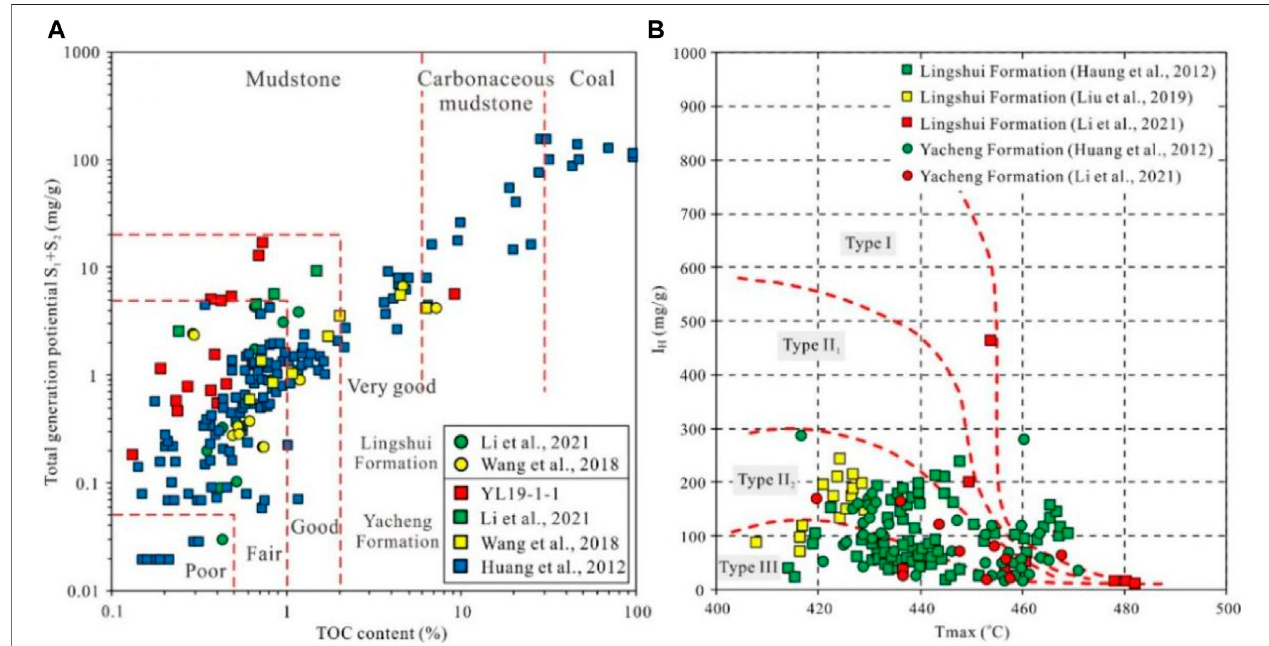
FIGURE 3 | (A) Hydrocarbon generation potential evaluation and (B) organic matter types of the Yacheng and Lingshui formations in the QDNB.